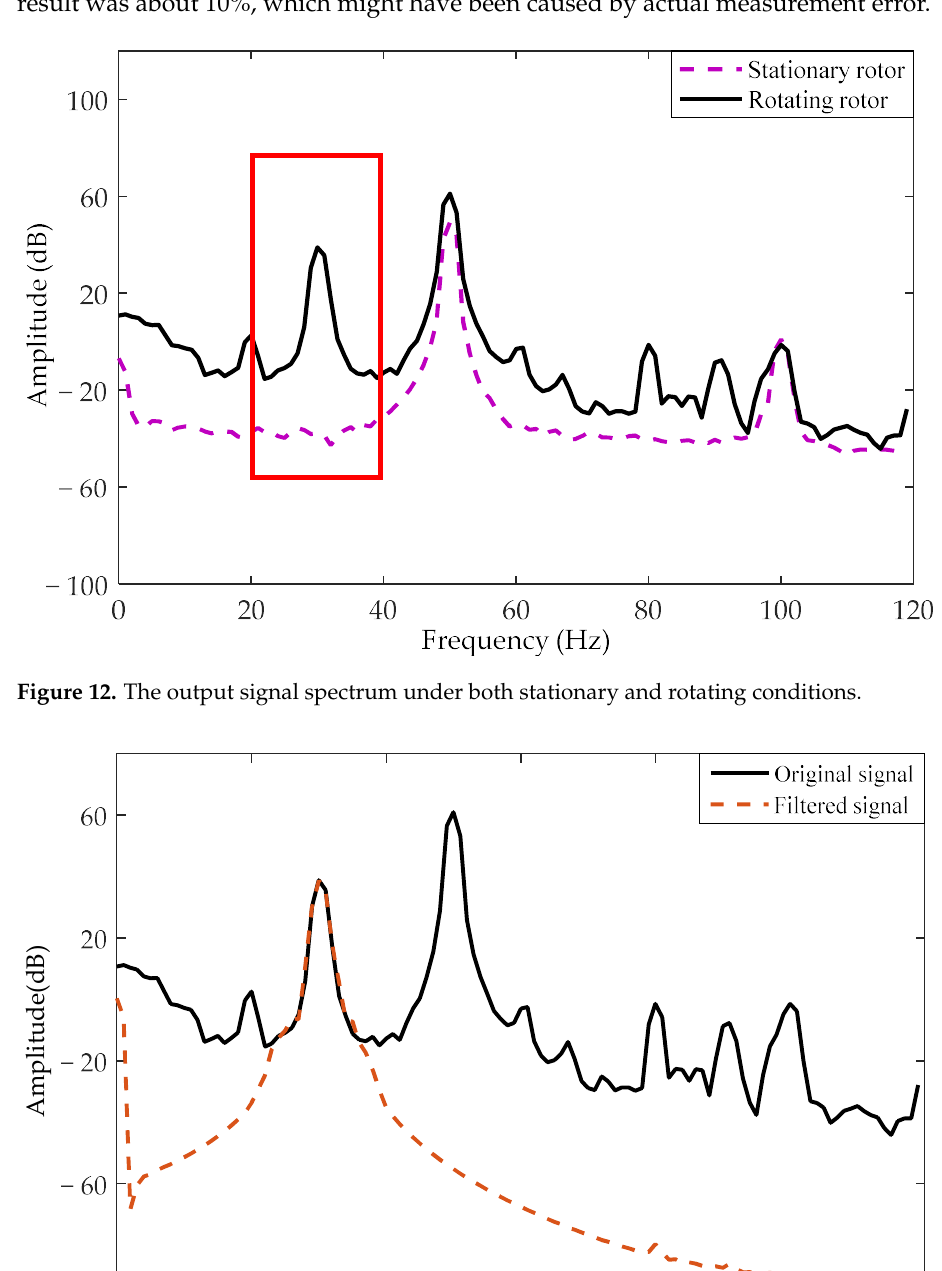
Figure 11. The experimental system for rotor motion .